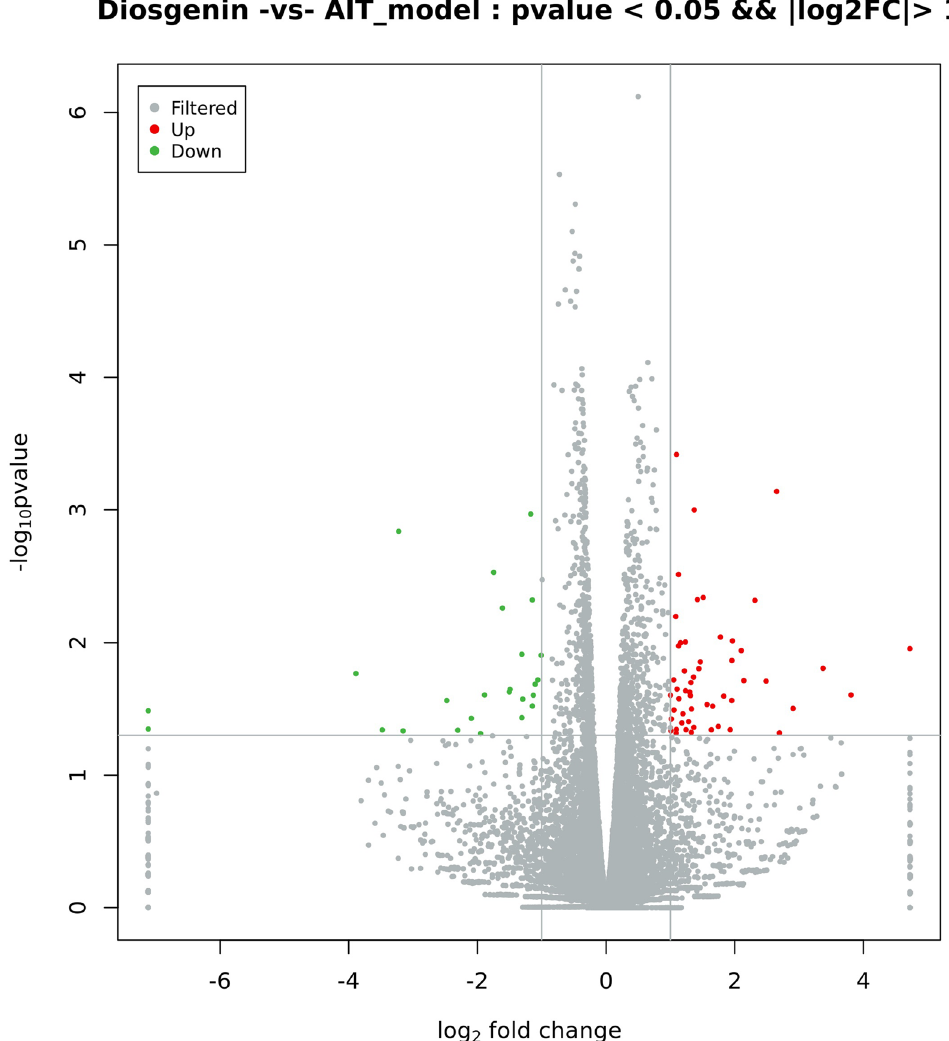
Figure 2. Differential expression volcano map. Photo caption: Reflection of the differences caused by comparison in the volcanic map: gray represents those genes with no significant difference, red and green represent the genes with significant differences; the x-axis displays log2FoldChange, and the y-axis displays